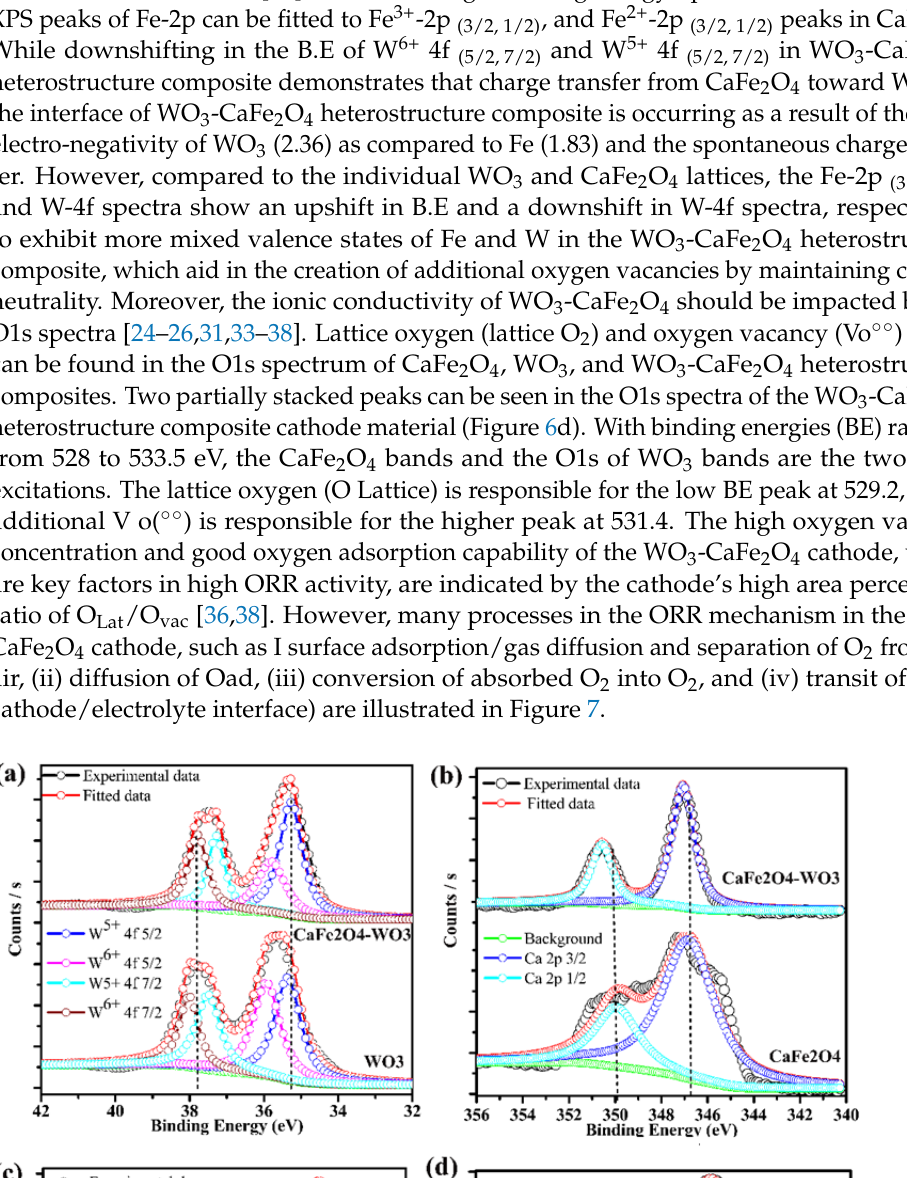
Figure 7. Schematic diagram of the different steps and electrochemical processes involved in power output of WO 3 ‐ CaFe 2 O 4 based cathode fuel cell. 4. Conclusions